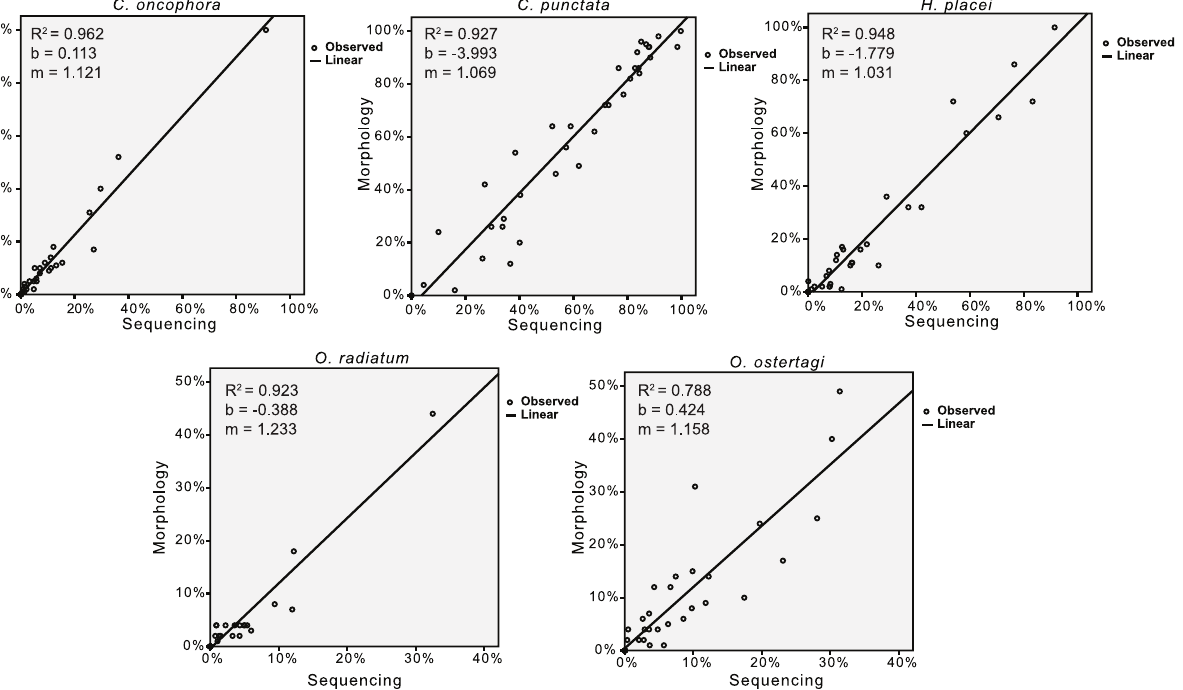
Fig 6. Comparison of the amplicon sequencing assay with visual morphological identification of larval populations from field samples. Fecal samples were collected from 39 individual calves entering feedlots from pasture at different locations in Oklahoma, Arkansas and Nebraska. 100 L3 larvae harvested from each coproculture were fixed and identified to the species level on the basis of morphological features on microscopy. The amplicon sequencing assay was applied to several hundred to several thousand L3 larvae from each sample. Fig 6A . Two bars are shown for each sample on the chart. The left bar of each sample shows the species proportions as determined by larval morphology. The right bar of each sample shows the proportions of